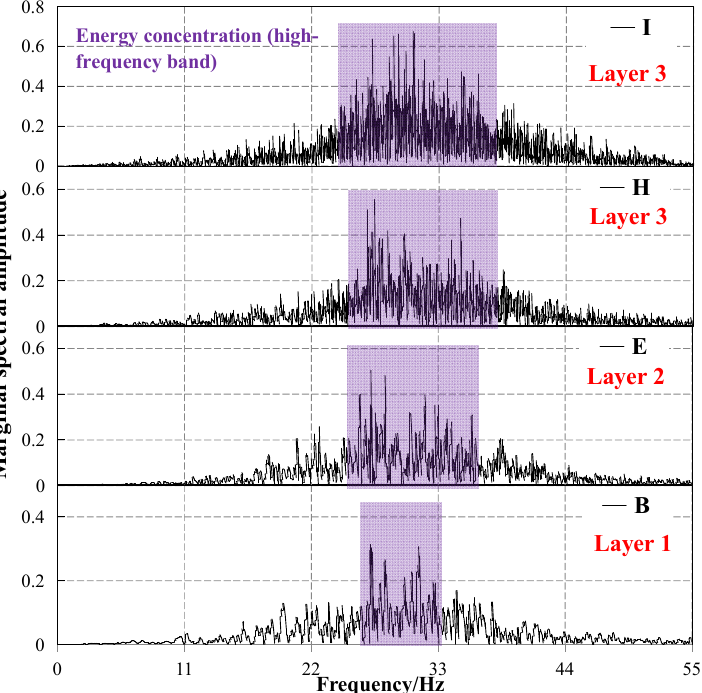
Figure 16. The marginal spectrum of different measuring points (I, H, E, and B) of Model 2.